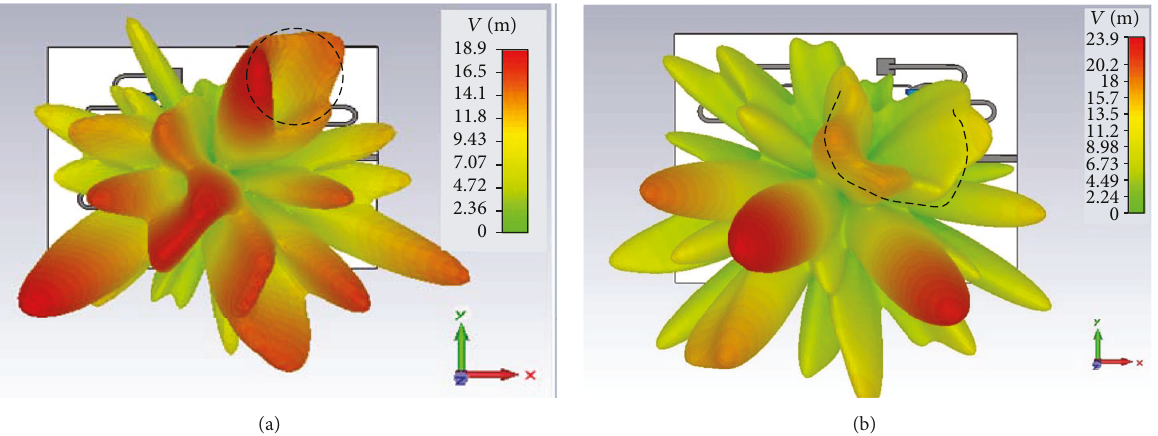
Figure 8: Radiation pattern of twisted wave steering antennas for (a) OAM mode 1 and (b) OAM mode